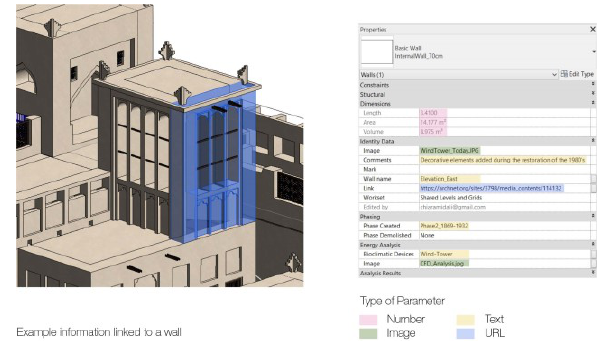
Figure 6. The third step is based on HBIM enrichment. The information mapping allows improving the different type of BIM-based analysis such as material stratigraphy, physical and thermal analyses.